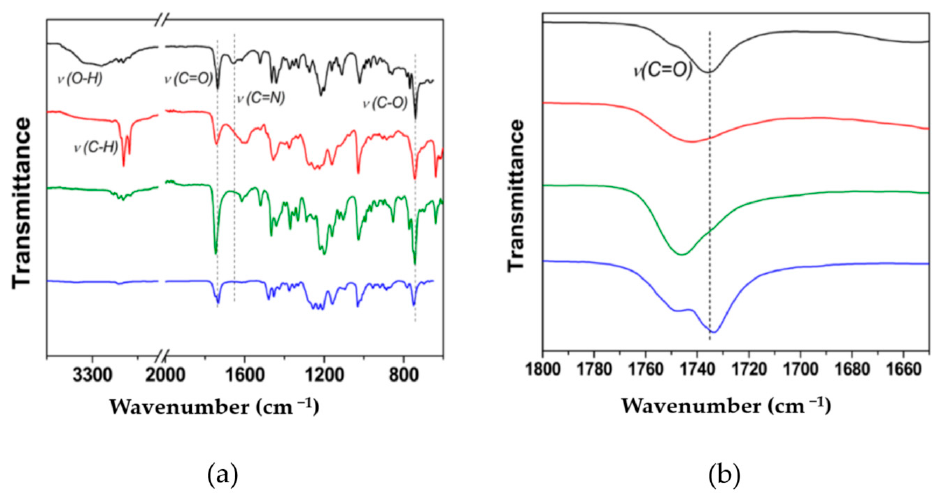
Figure 2. Infrared spectra of BimOEt 3 (black trace), Eu III complex (red trace), Tb III complex (green trace), and Ce III complex (blue trace) with assignment of relevant vibrational frequencies shown in ( a ) full and ( b ) selected carbonyl stretching region.